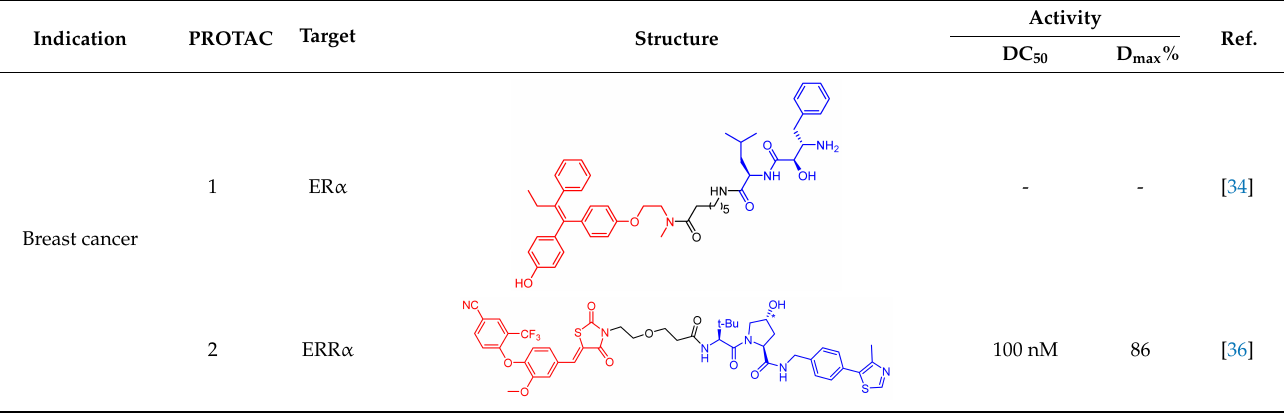
Table 1. Representative PROTACs for